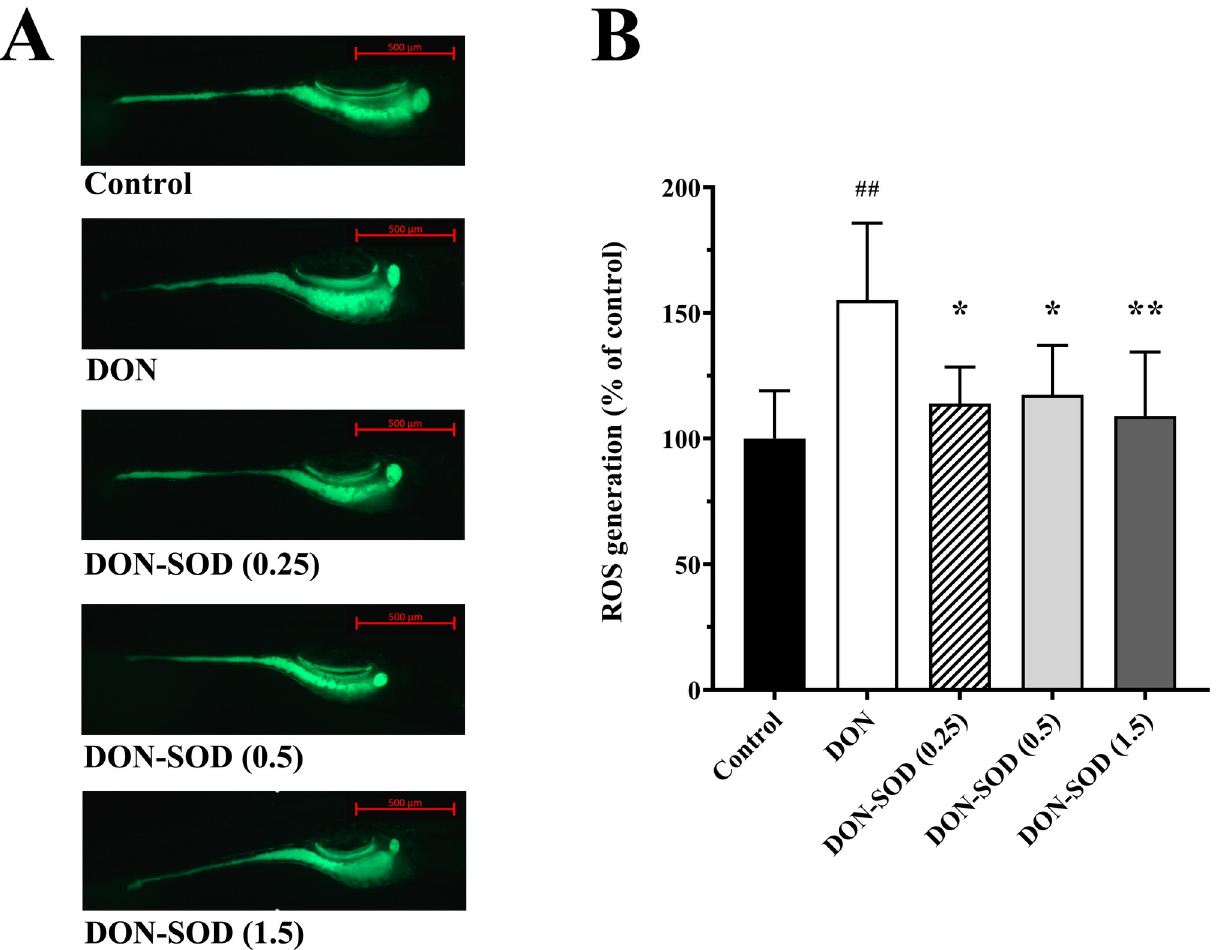
Fig 4. Effects of DON and Aa SOD product on ROS accumulation in zebrafish. (A) Fluorescence images of ROS generation in zebrafish of different groups. In the control group, zebrafish were cultured without adding DON or Aa SOD. For each group except the control group, DON was added to the culture water to a concentration of 3 ppm. Aa SOD was not supplied in the DON group, while was supplied at concentrations of 0.25 U mL -1 , 0.5 U mL -1 , or 1.5 U mL -1 in the DON-SOD (0.25) group, DON-SOD (0.5) group, or DON-SOD (1.5) group. (B) The quantified fluorescence intensities of zebrafish in different groups. The IOD values analyzed by Image-Pro Plus software were adjust using the mean value of control group as 100%. The data are expressed as the mean ± SD of eight zebrafish. The significance of each DON-added group vs control group was analyzed with t -test, and ## represents p < 0.01. The significance among the 4 DON-added groups were analyzed with ANOVA, and � represents p < 0.05 and �� represents p < 0.01 vs the DON group.